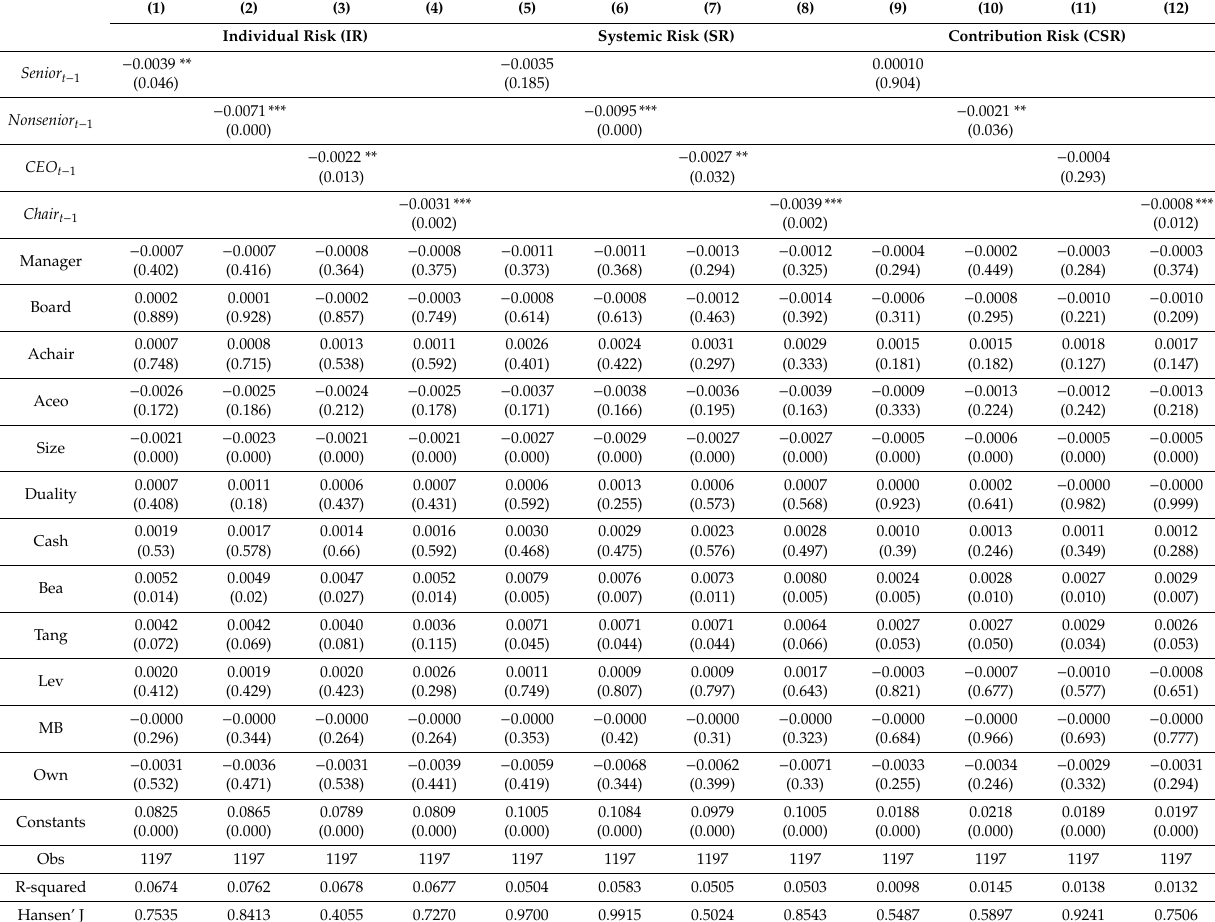
Table 5. Generalized method of moments (GMM)